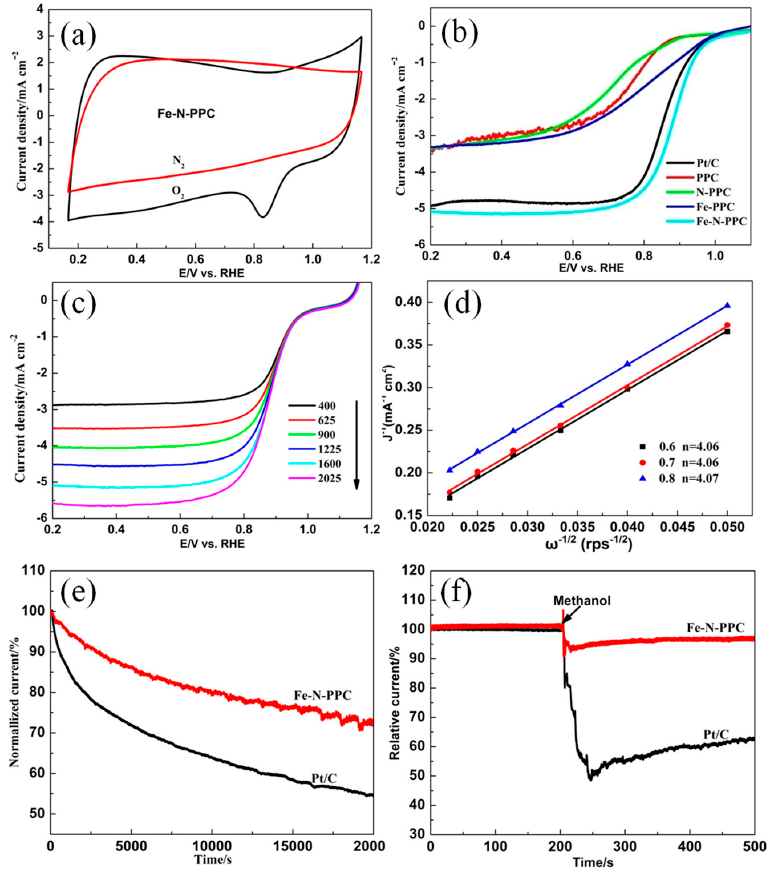
Figure 5. ( a ) The cyclic voltammetry (CV) curves of Fe-N-PPC at a scan of 50 mV/s; ( b ) LSV curves of PPC and other samples at a scan rate of 10 mV/s and an electrode rotation rate of 1600 rpm; ( c ) LSV curves of Fe-N-PPC at various rotation rates and a scan rate of 10 mV/s; ( d ) Corresponding K–L plots at different potentials; ( e ) Long-term stability test of Fe-N-PPC and 20% Pt/C in a 0.1 M KOH solution; ( f ) Methanol (3 M) crossover resistance test.